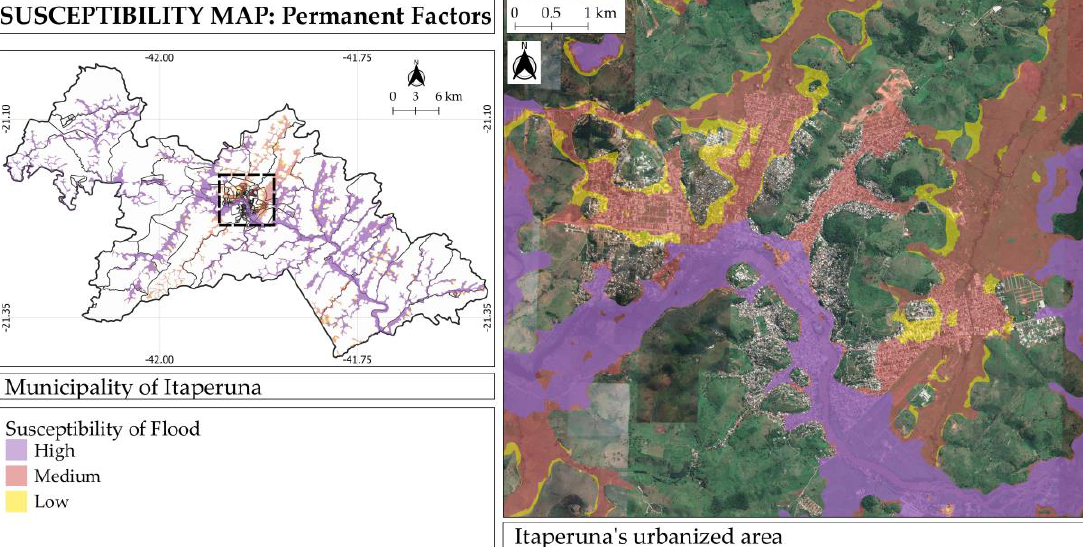
Figure 7. Flood susceptibility map (based on permanent factors) of the municipality of Itaperuna categorized by high, medium, and low susceptibility ratings.